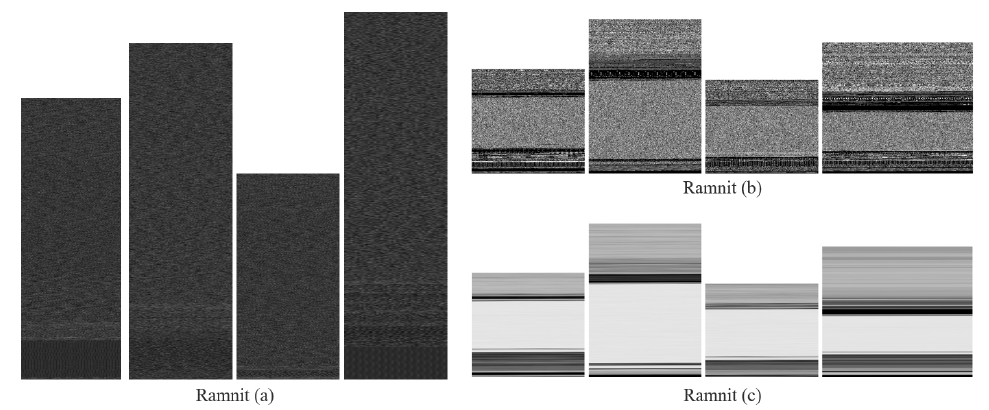
Figure 2. Generated grayscale images of malware using three different methods.